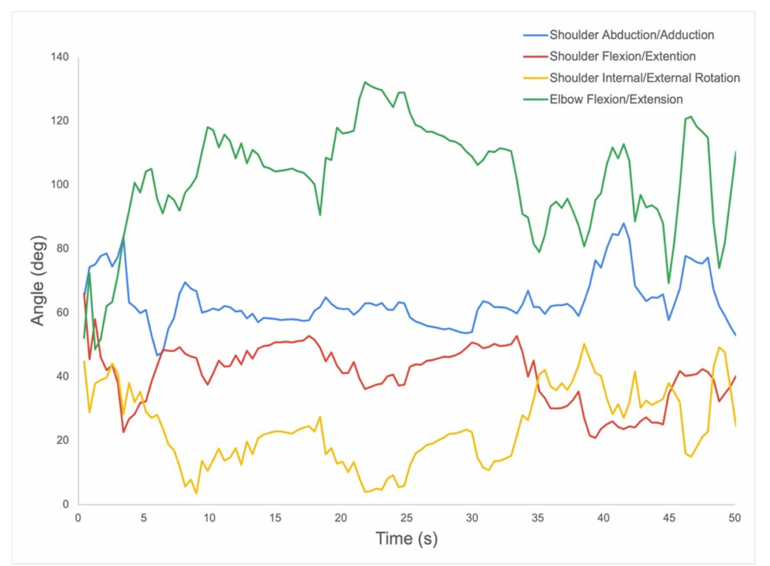
Figure 10. The upper limb joint angles as calculated based on the Kinect sensor data during the same session as in Figure